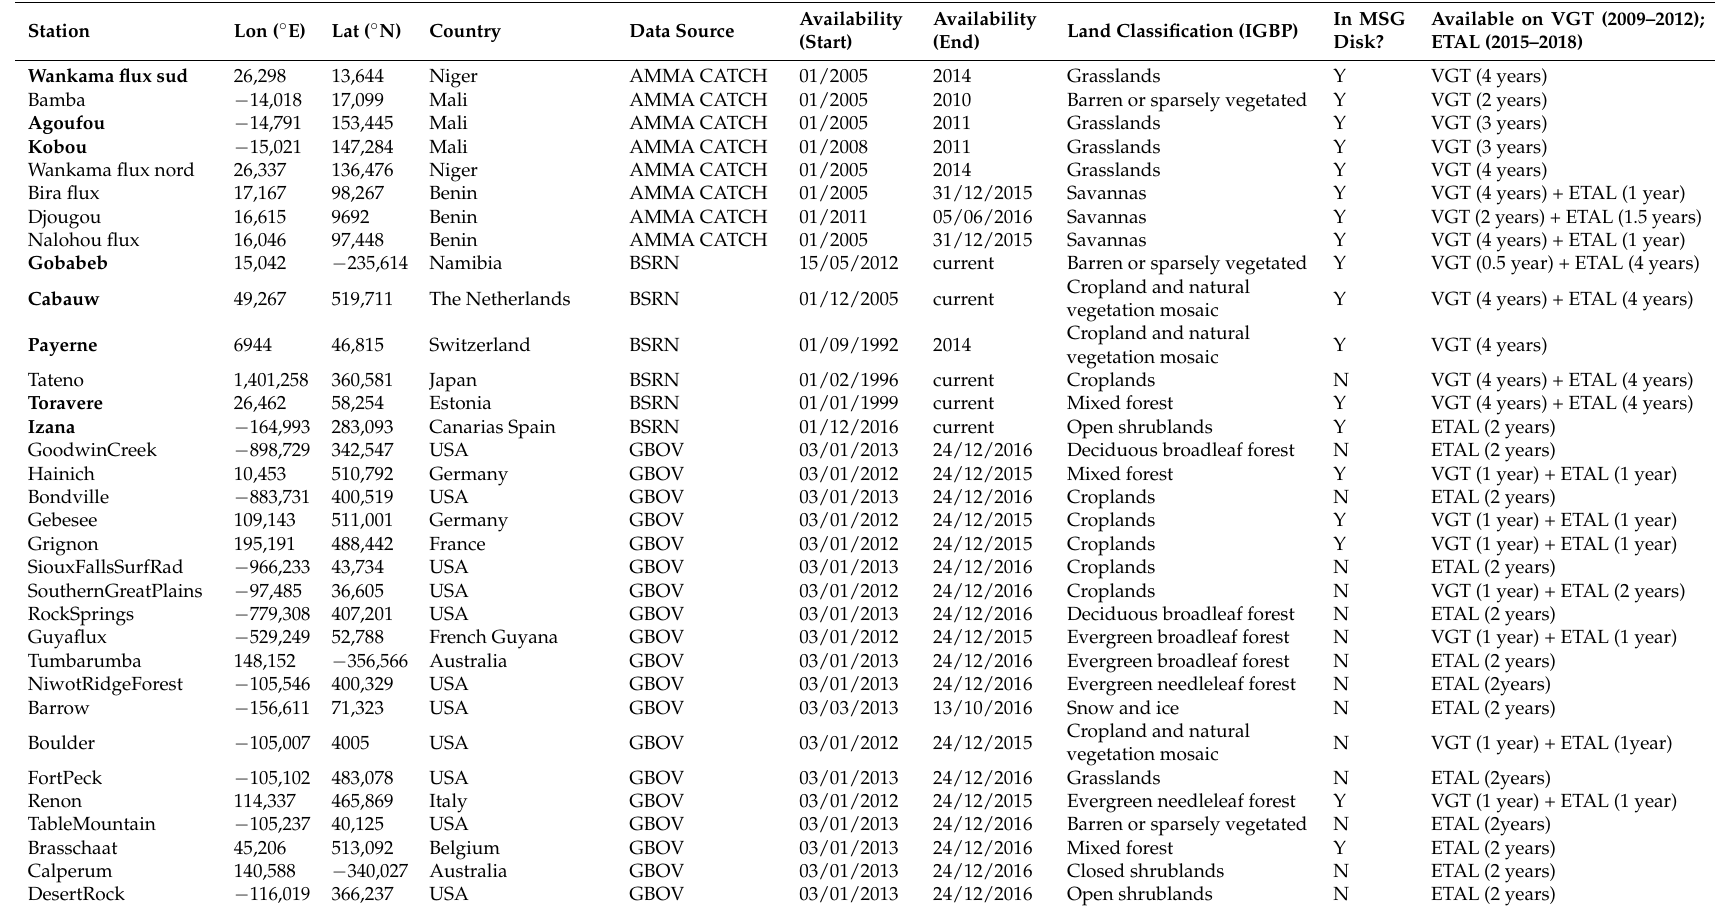
Table 3. List of all ground stations used for the accuracy